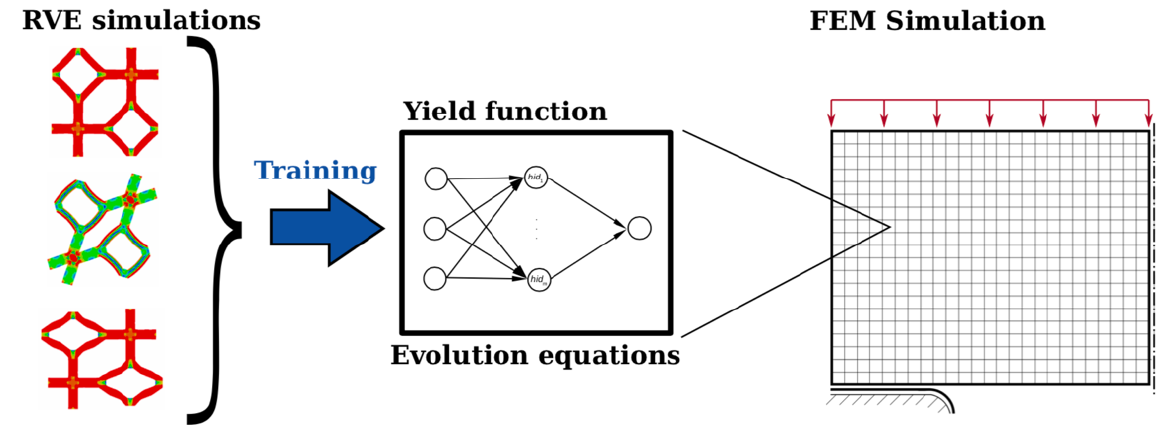
Figure 9. Graphical illustration of machine learning approach by Settgast et al. [45].